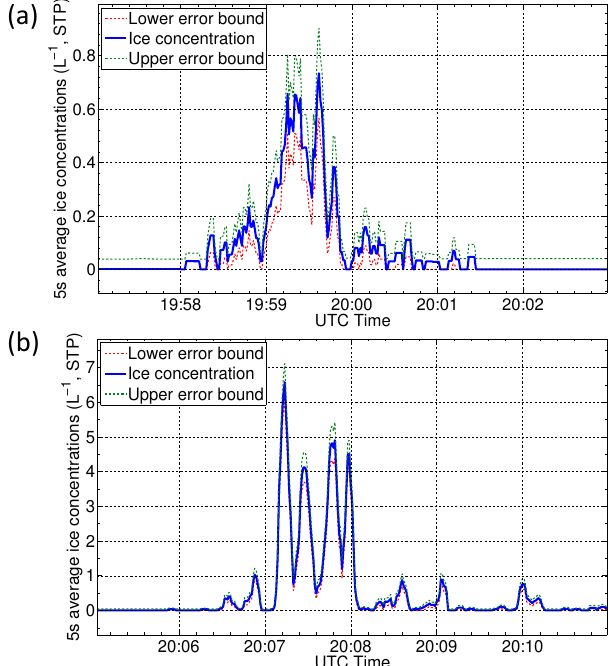
Fig. 8. As for Fig. 5c except for: (a) – the lower ice concentra- tion Hallett Mossop period; (b) – the higher concentration Hallett Mossop zone period. See text for details. Also, the averages here are over the shorter period of